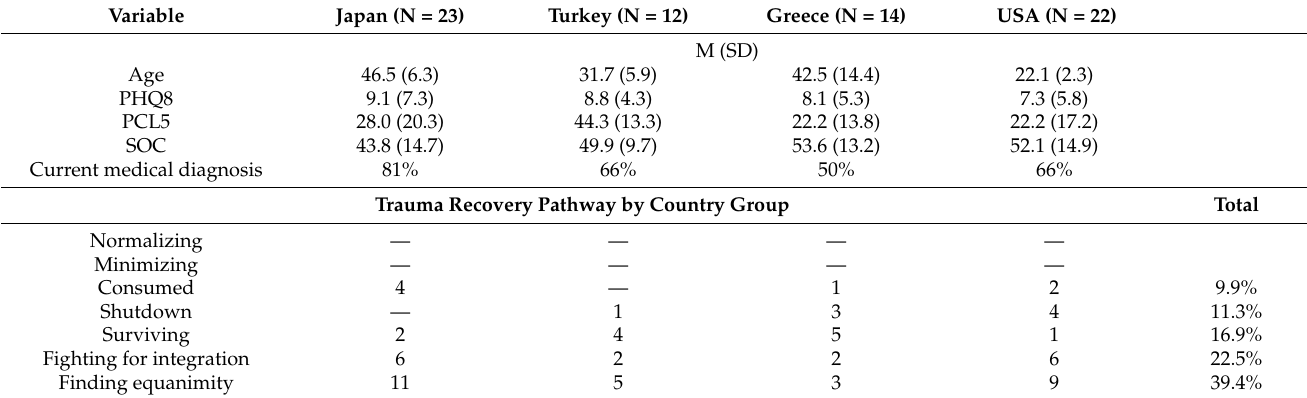
Table 3. Sample characteristics GBV survivors (N = 71) and pathway of trauma recovery per country.